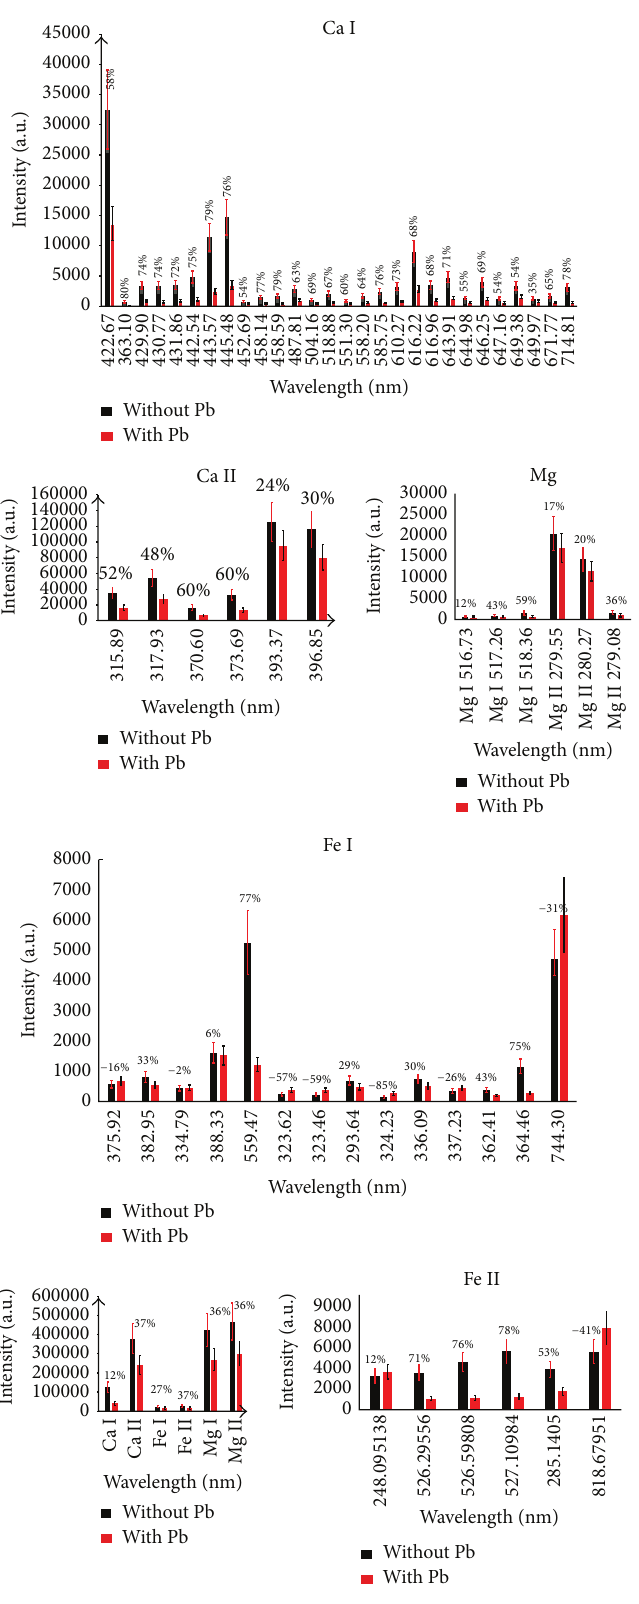
Figure 6: Comparison of relative intensity of different element presented in both